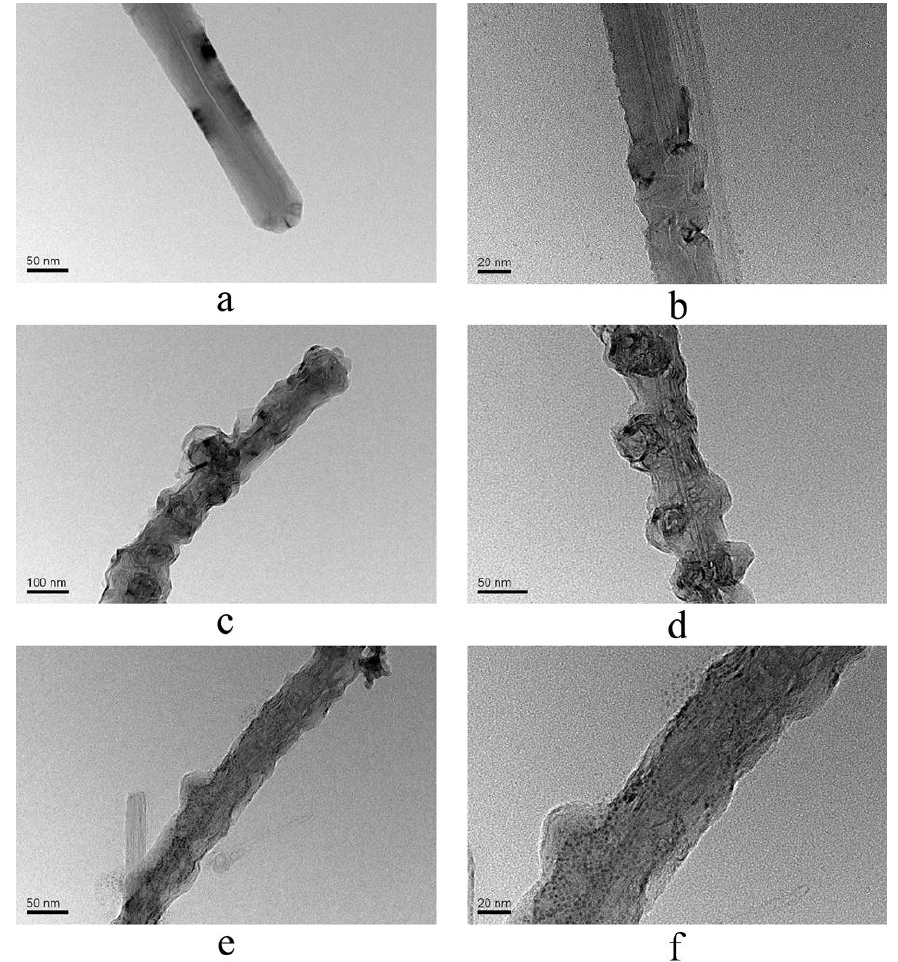
Figure 4. TEM image of the CNFs, AN-CNFs and CoTCPcNa-AN-CNFs. ( a ) CNFs at 50 nm; ( b ) CNFs at 20 nm; ( c ) AN-CNFs at 100 nm; ( d ) AN-CNFs at 50 nm; ( e ) CoTCPcNa-AN-CNFs at 50 nm; ( f ) CoTCPcNa-AN-CNFs at 20